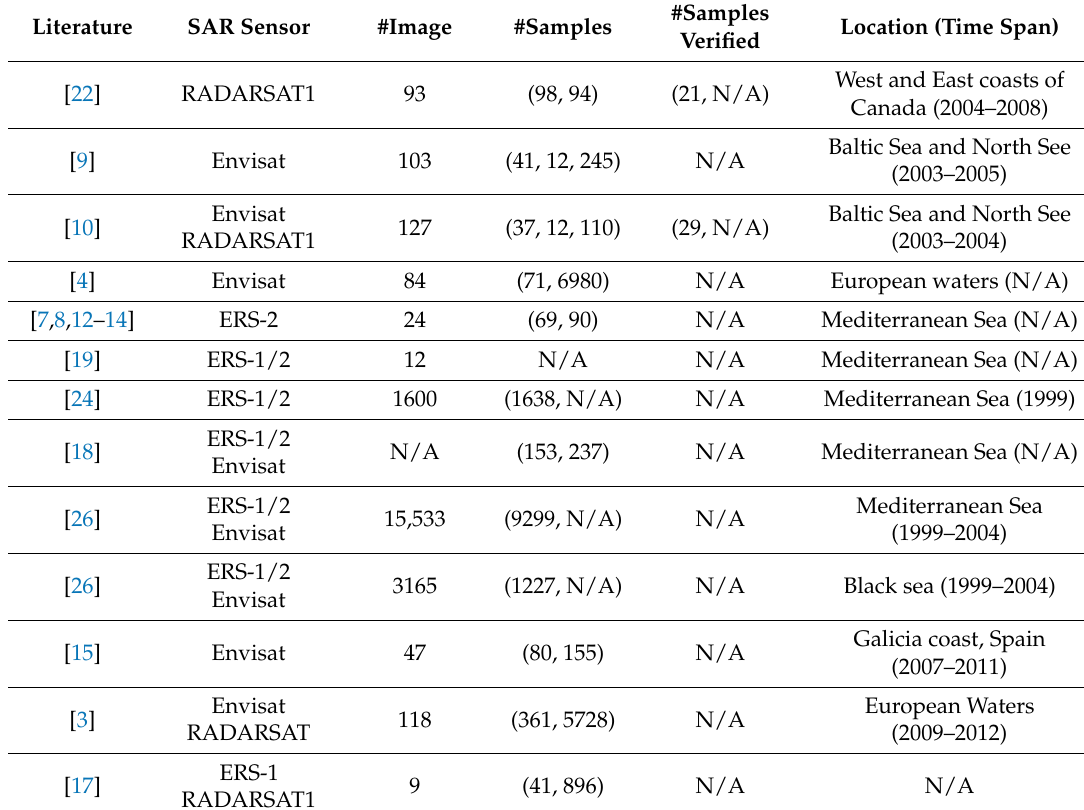
Table 1. Summary of the dataset adopted in different SAR oil spill detection researches. Note that in the #samples column; (X, Y) indicates there are X oil spills and Y look-alikes and, in the #Samples verified column; (X, Y) indicates there are X verified oil spills and Y verified